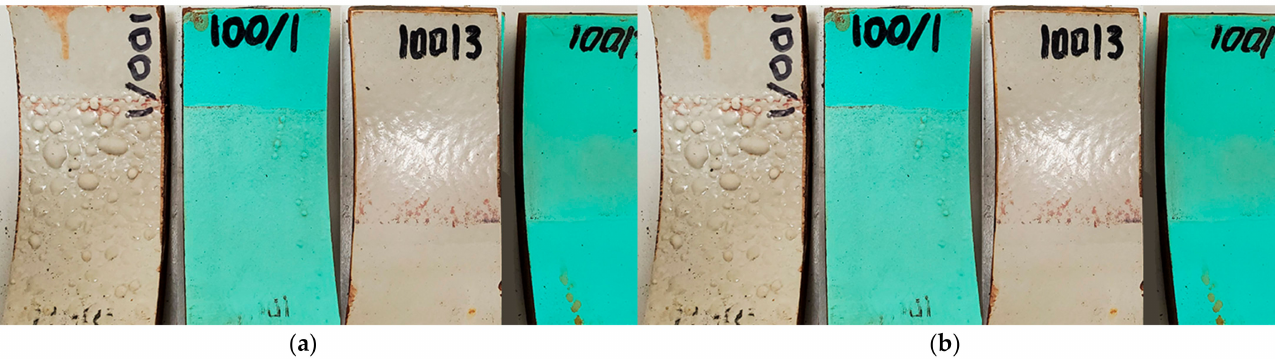
Figure 7. Samples after autoclave decompression tests with different duration of exposure under the same conditions: ( a ) exposure for 24 h; ( b ) exposure for 72